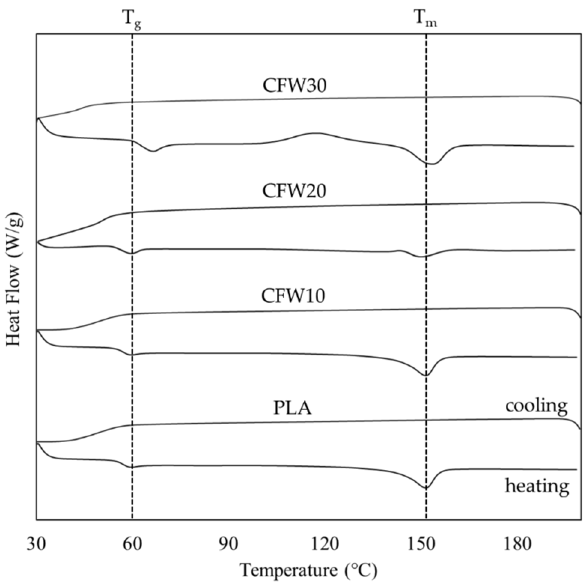
Figure 8. DSC thermograms. Table 3. Thermal property data of the PLA/CFW composites. Table 3. Thermal property data of the PLA/CFW